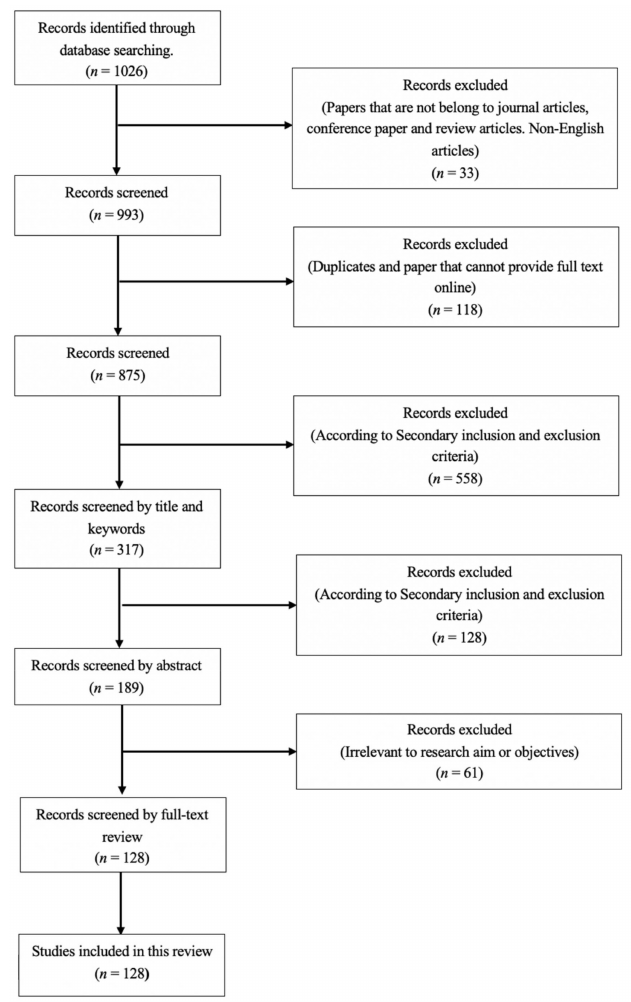
Figure 1. Flowchart of articles screened in this